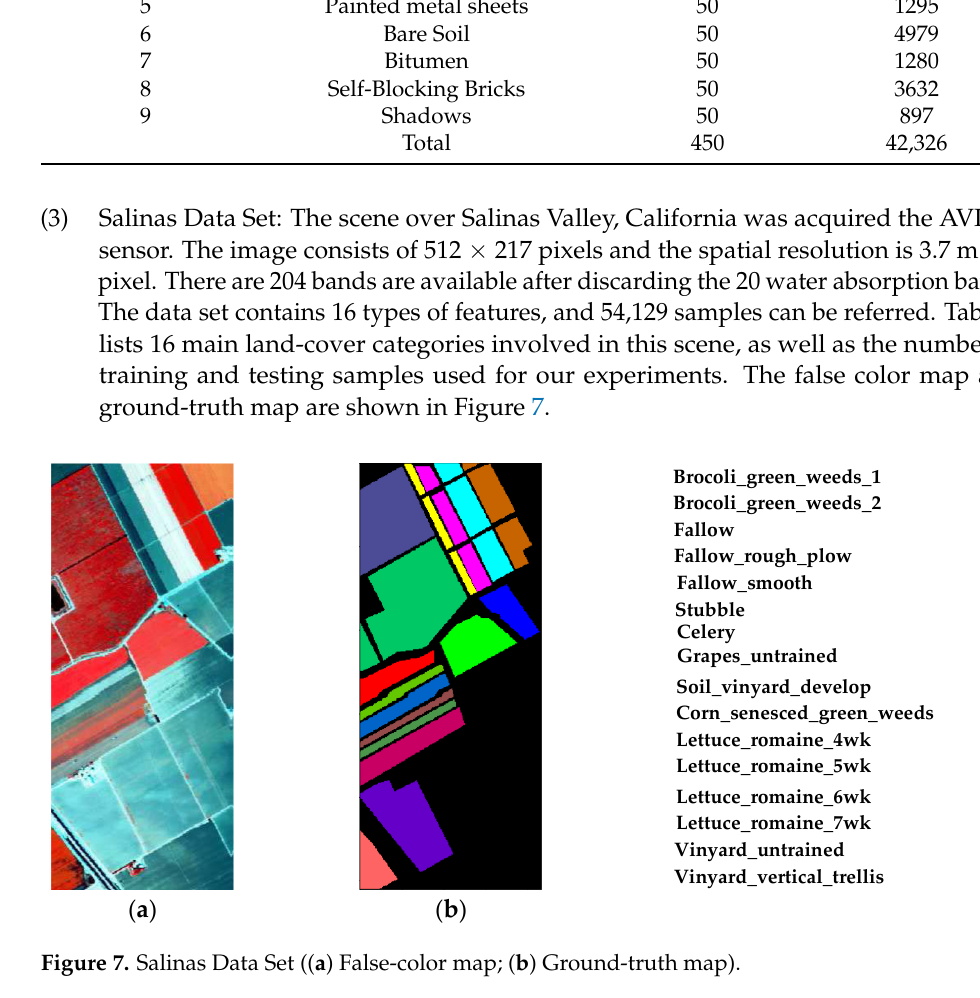
Table 3. Number of training and test sets for the Pavia University data set.